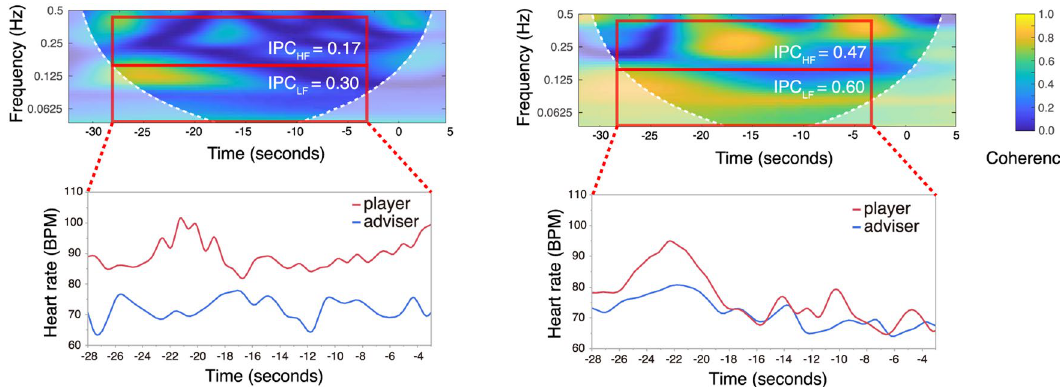
Figure 2. Examples of wavelet transform coherences (WTCs) and interpersonal physiological coherence (IPC). Sample WTCs between a player’s and an adviser’s IBIs in the top images, and a time-series of heart rates for a player ( red lines ) and an adviser ( blue lines ) in the bottom images. All x-axes represent the timeline, with time zero seconds marking the start of block-pull timing (see Fig. 1 for details). The wavelet coherence is represented by colour. The plot on the left is an example of a turn with relatively weak synchrony, and the plot on the right shows a turn with relatively strong synchrony. The squares outlined in red in the WTC plots show coherence values for the 25-s period of interest in each of the high (upper squares: 0.15–0.40 Hz) and low-frequency bands (lower squares: 0.04–0.15 Hz). IPC was calculated by averaged coherence values in each square (top squares: IPC HF ; bottom squares: IPC LF ); however, the cone of influence (COI) areas of the WTCs, which are a lighter shade, were not included in the IPC